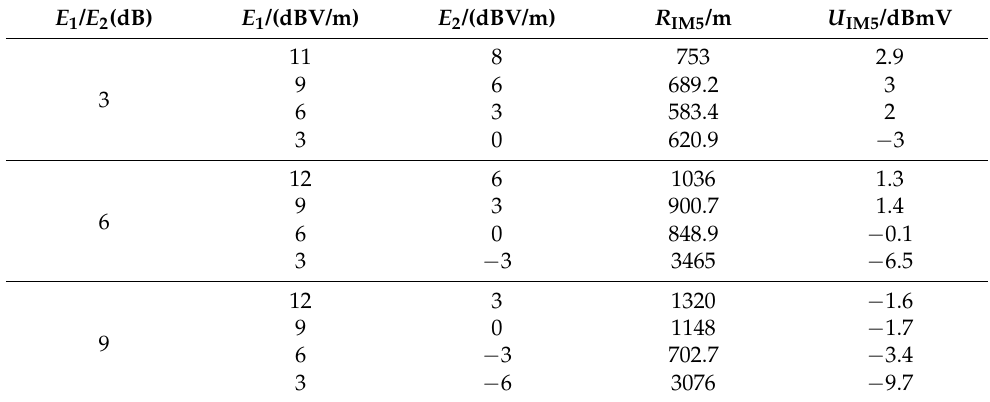
Table 4. Test results of theIMFA − 5 with the same proportional change of interference field strength.